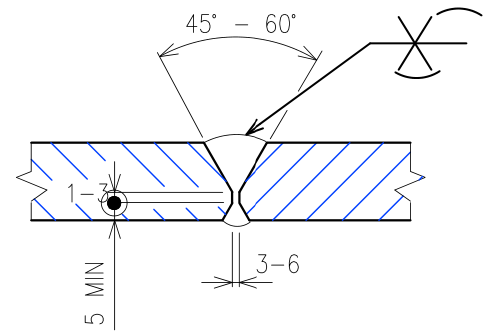
Figure 2. Weld detail of transverse butt-welded Figure 3. Weld detail of transverse butt-welded joint.